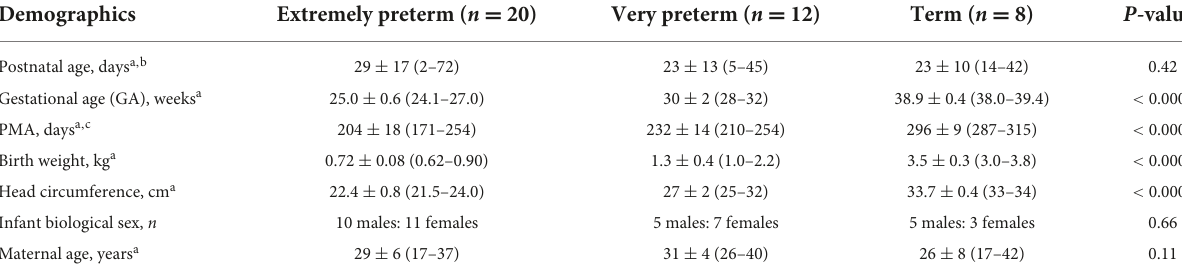
TABLE 1 Demographic description of lactating women who donated human milk